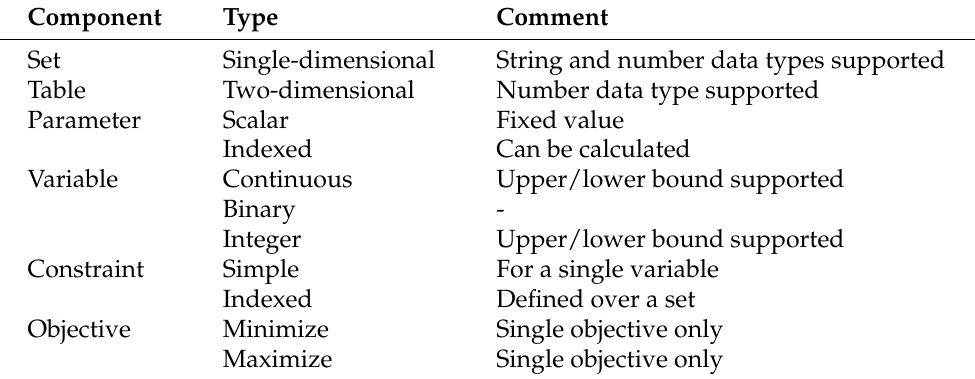
Table 5. Basic components of WebAML language.